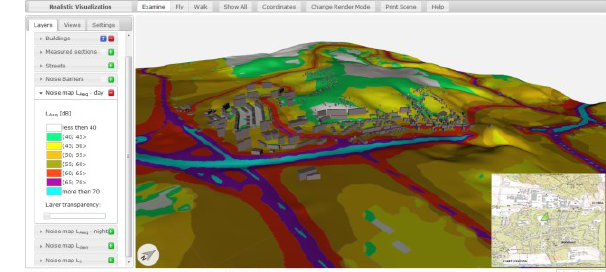
Figure 3. An example of the graphical user interface of the developed